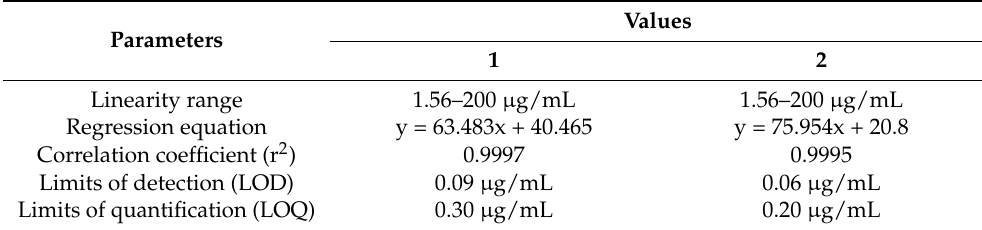
Figure 2. HPLC-DAD chromatograms of ( a ) 100 µg/mL T. grandis leaf-hexane extract, ( b ) 100 µg/mL T. grandis leaf-ethanolic extract, and ( c ) a mixture of 50 µg/mL isolated compounds 1 and 2 . Table 2. Method validation parameters for the determination of 1 and 2 by the proposed HPLC method.